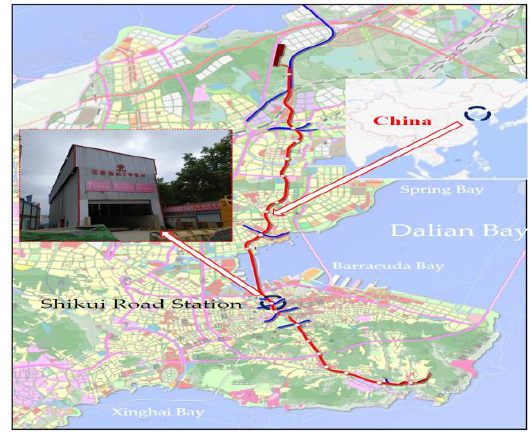
Figure 4. The project location map